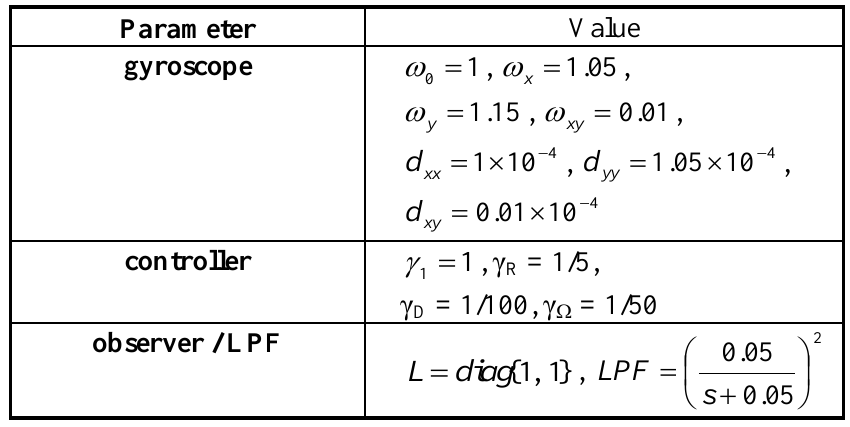
Table 1. Non-dimensional values of the control